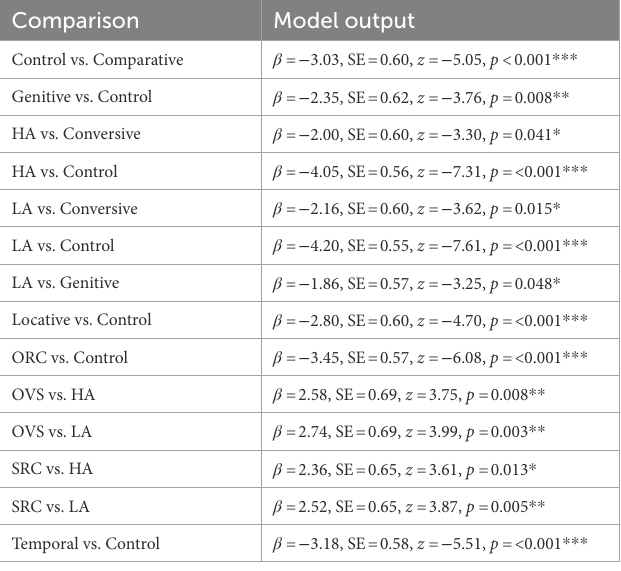
TABLE 2 Significant model outputs for accuracy analysis in the pilot study. Comparison Model